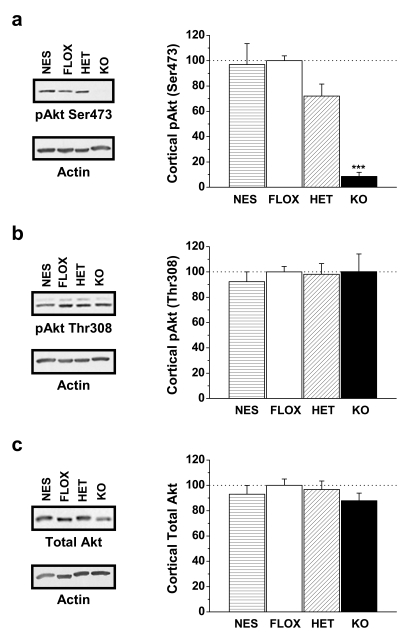
Neuronal rictor deletion specifically abolishes Akt phosphorylation at Ser473 in the cortex.(A) Phosphorylation of Akt on residue Ser473 in the cortex. (B) Phosphorylation of Akt at Thr308 and (C) total Akt in the cortex are similar for all genotypes. Shown are mean±s.e.m of optical densities as a percentage of FLOX control mice. Genotypes shown include animals expressing only nestin-CRE (NES), mice expressing two copies of the “floxed” rictor allele (FLOX) only, heterozygous mice which express nestin-CRE and a single copy of the “floxed” rictor allele (HET), and knockout mice expressing both nestin-CRE and two copies of the “floxed” rictor allele (KO). Total cortical protein extract was loaded in each lane. Representative immunoblots are shown, as probed with antibodies to phosphorylated Akt at Ser473 (A) Thr308 (B), total Akt (C), and actin to serve as a loading control. Samples n = 9–16. ***p<0.001 one-way ANOVA.